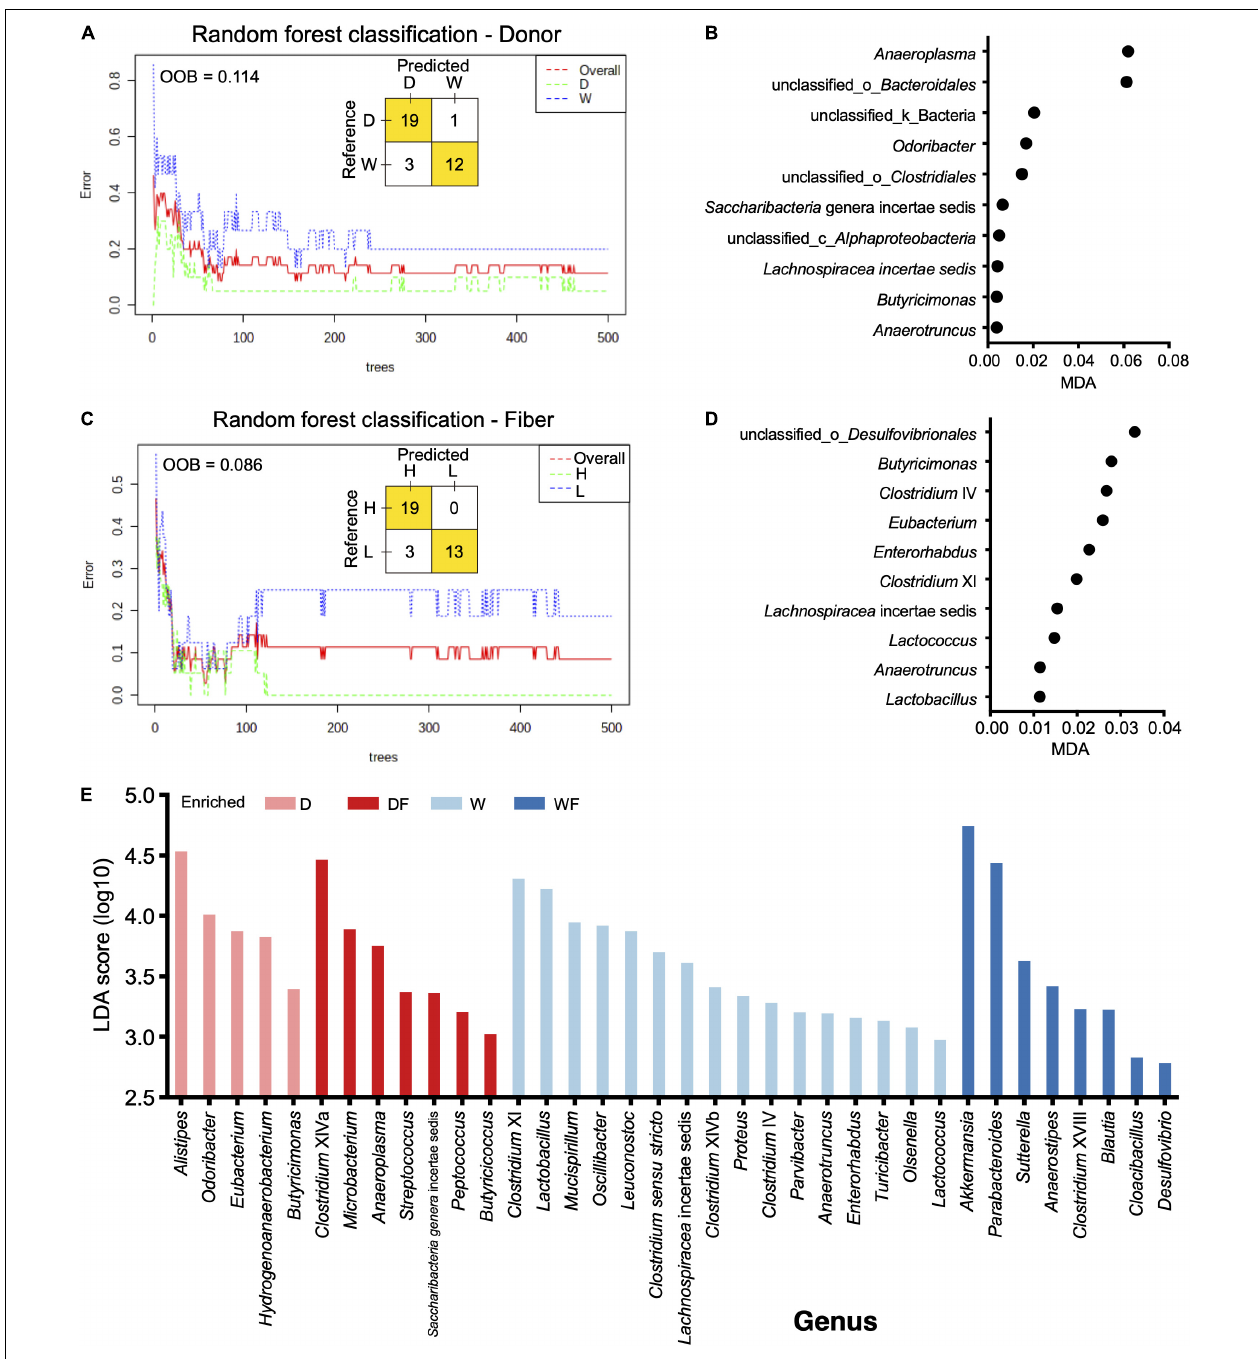
FIGURE 5 | Random forest (RF) model and linear discriminant analysis effect size revealed differential genera between mice with different treatments. (A) RF model constructed for classification mice transplanted domestic pig (D) and wild boar (W) fecal bacteria. (B) Bacteria genera with top 10 mean decrease accuracy selected by RF model for classification of donor effect. (C) RF model constructed for classification mice treated with low-fiber (L) and high-fiber (H) diets. (D) Bacteria genera with top 10 mean decrease accuracy selected by RF model for classification of diet effect. (E) Bar plot of linear discriminant analysis score of bacteria genera selected by linear discriminant analysis effect size (linear discriminant analysis score >